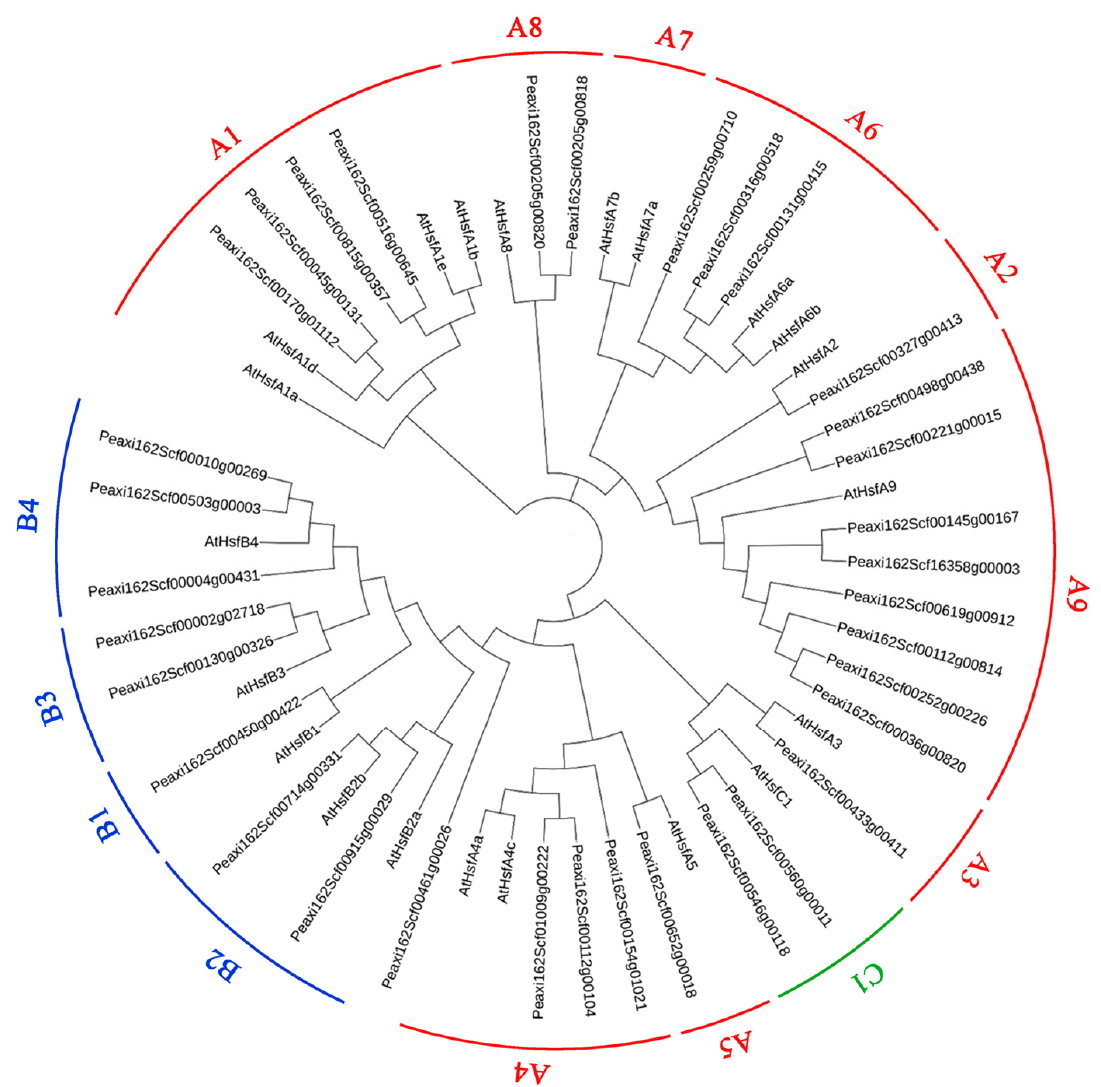
Figure 2. Phylogeny analysis of petunia HSFs with AtHSFs from Arabidopsis thaliana . HSFs were divided into three major subfamilies HSFA (red), HSFB (blue), and HSFC (green).